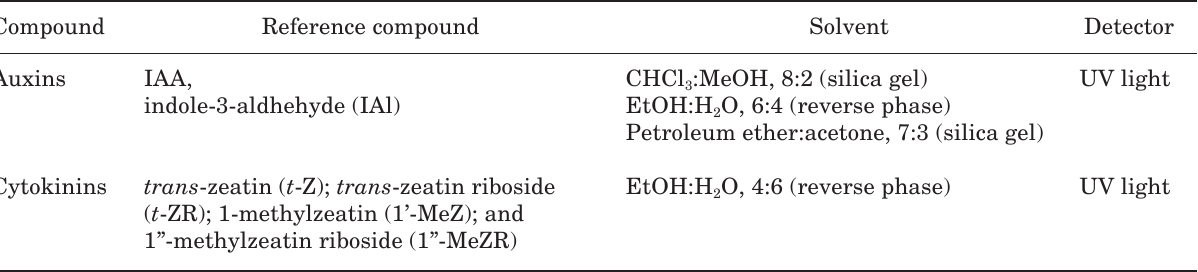
Table 1. TLC methods for the analysis of indoles and cytocinins produced by Pantoea agglomerans.